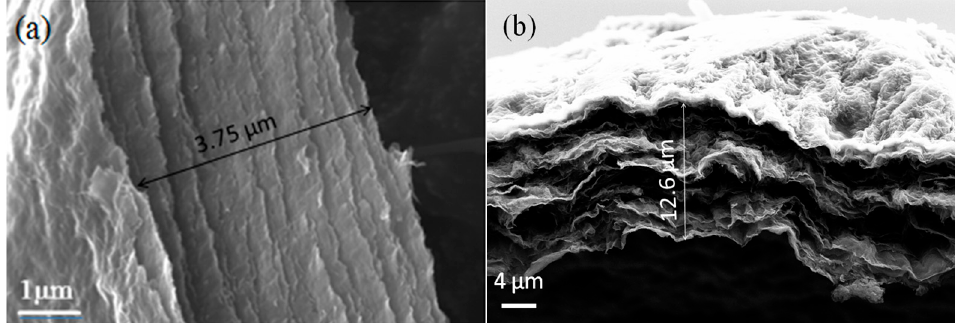
Figure 5. The SEM pictures of the cross-section of ( a ) the pure graphene sheet and ( b ) the graphene-Fe 2 O 3 sheet.